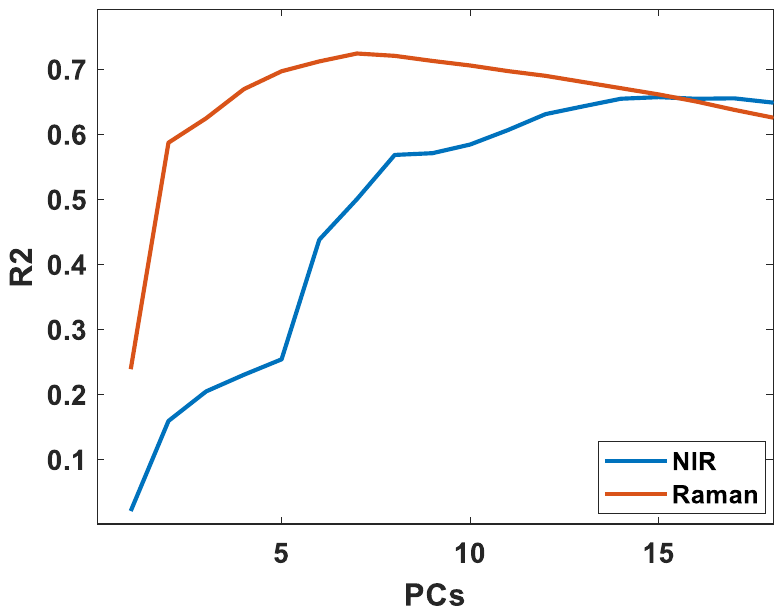
Figure 3. The cross-validated performance of DHA using NIR and Raman